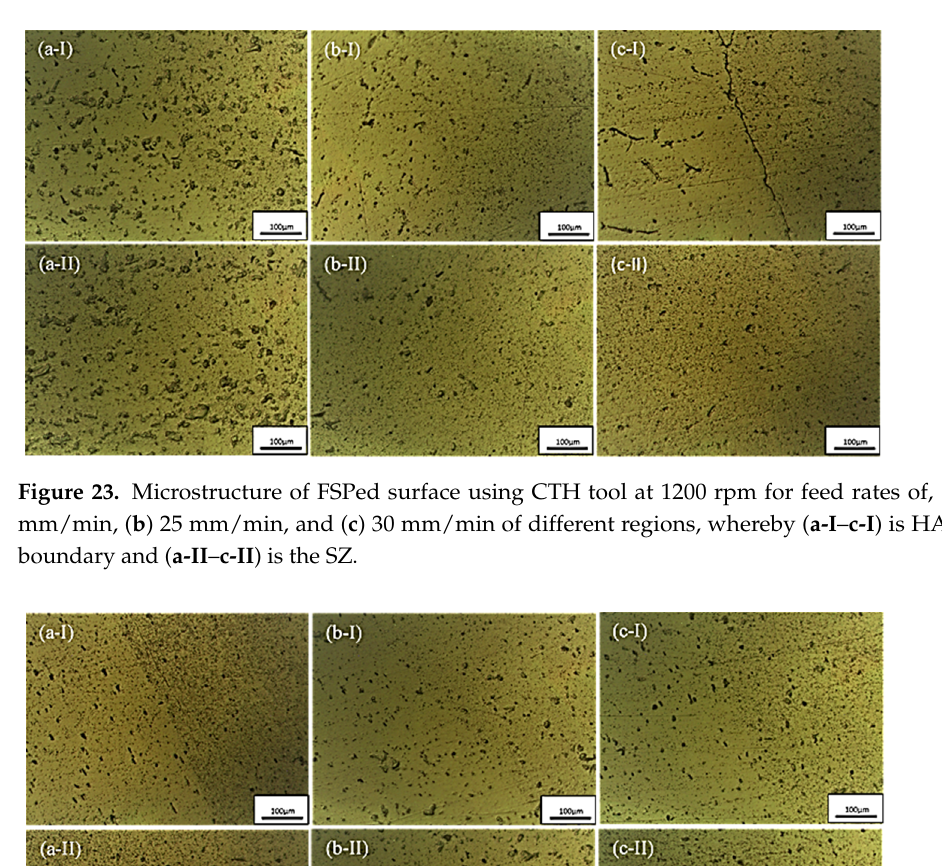
Figure 22. Microstructure of FSPed surface using CTH tool at 1150 rpm for feed rates of, ( a ) 20 mm/min, ( b ) 25 mm/min, and ( c ) 30 mm/min of different regions, whereby (a-I–c-I) is HAZ-SZ boundary and (a-II–c-II) is the SZ.